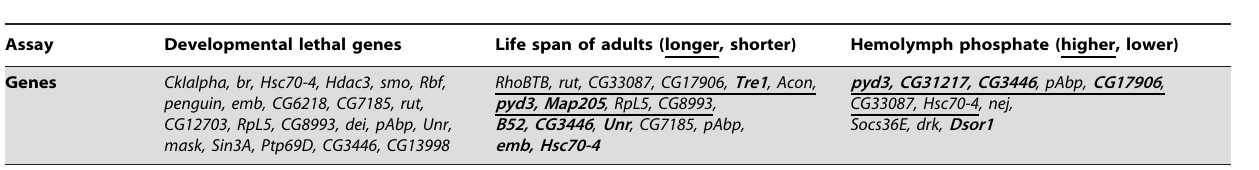
Assay Developmental lethal genes Life span of adults (longer, shorter) Hemolymph phosphate (higher, lower) RhoBTB, rut, CG33087, CG17906, Tre1 , Acon, pyd3,CG31217,CG3446 , pAbp, CG17906 , Genes CkIalpha, br, Hsc70-4, Hdac3, smo, Rbf, pyd3,Map205 , RpL5, CG8993, CG33087, Hsc70-4, nej, penguin, emb, CG6218, CG7185, rut, Socs36E, drk, Dsor1 B52,CG3446 , Unr , CG7185, pAbp, CG12703, RpL5, CG8993, dei, pAbp, Unr, emb,Hsc70-4 mask, Sin3A, Ptp69D, CG3446, CG13998 Drosophila gene names for developmental lethal mutants and outliers in life span and hemolymph phosphate assays shown in Figures 6 and 7. Significance for longevity and hemolymph phosphate is based on Student’s t-test (p , 0.05). Bold script indicates genes that remain significant after Bonferroni’s correction for multiple comparisons when we used p , 0.003 for the life span assay based on 17 outliers and when we used p , 0.007 and p , 0.0125 for the hemolymph assay based on seven and four outliers, respectively. Underline script is used for longer/higher outliers, while regular script is used for shorter/lower outliers. (See Table S1 and Figs. 7, 8 for detailed results).